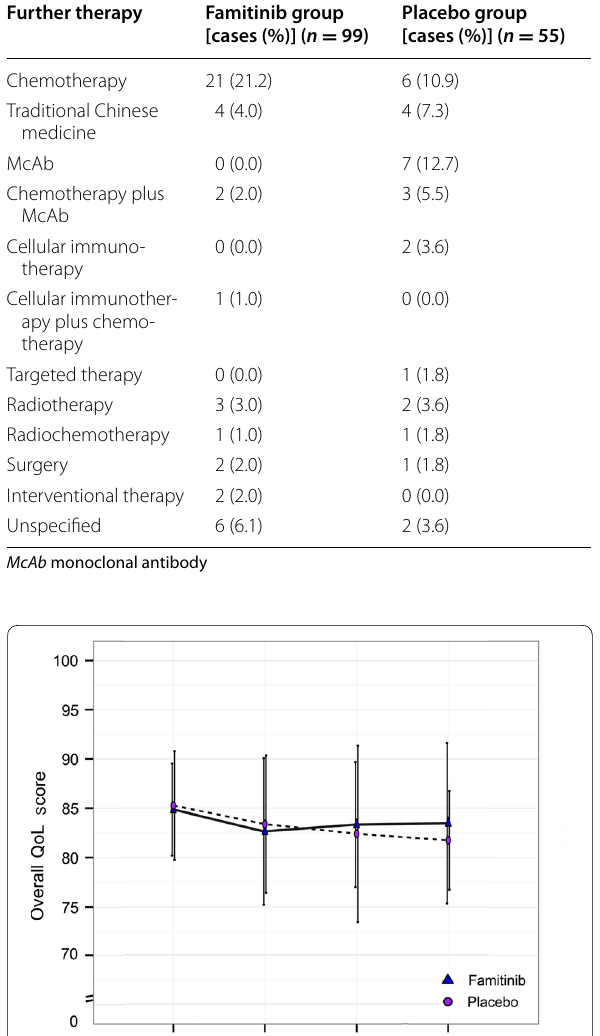
Table 4 Treatment-related